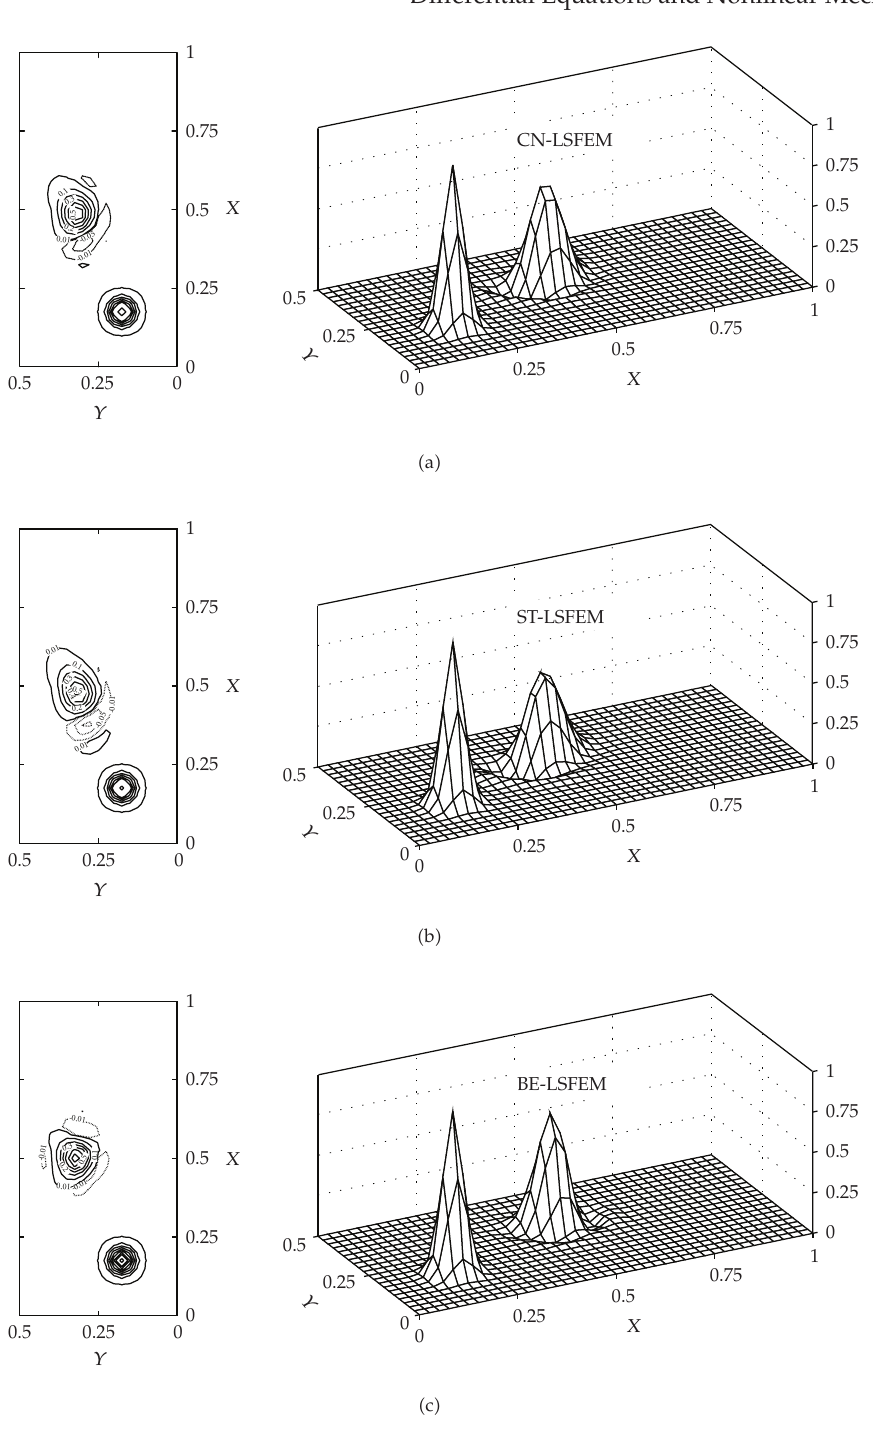
Figure 5: Convective transport of the concentration spike (cid:3) initial condition shown by the left cone (cid:4) with flow at 25 ◦ to x -axis for C (cid:9) 1 .